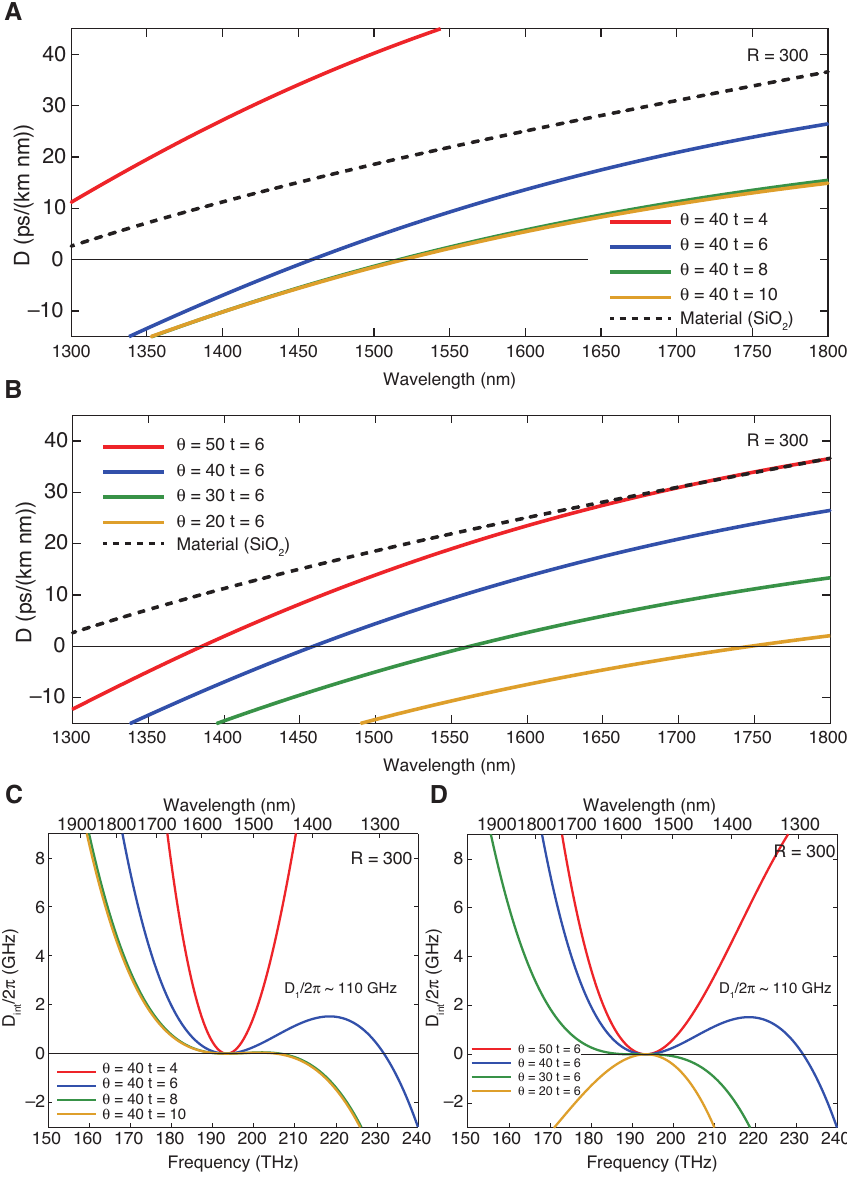
disk of 300 μ m radius for different angles θ and thicknesses t μ m. Figure 9: Simulated dispersion of SiO 2 (A) Dispersion parameter D for different disk thicknesses. (B) Dispersion parameter D for different disk angles. (C) Integrated dispersion D for different disk thicknesses. (D) Integrated dispersion D for different disk int